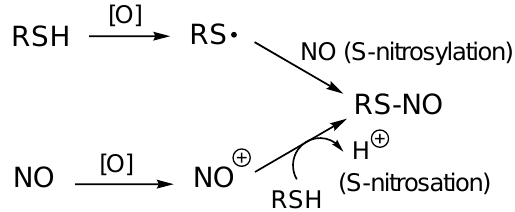
Figure 1. Possible pathways for the formation of RS-NO from RSH and NO. [O] denotes a one-electron oxidation.